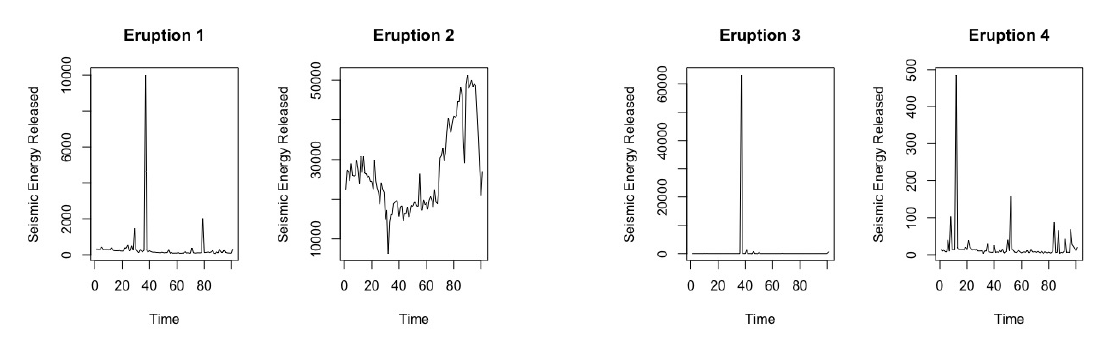
Figure 7. Plots of volcanic eruption numbers 1, 2, 3 and 4.